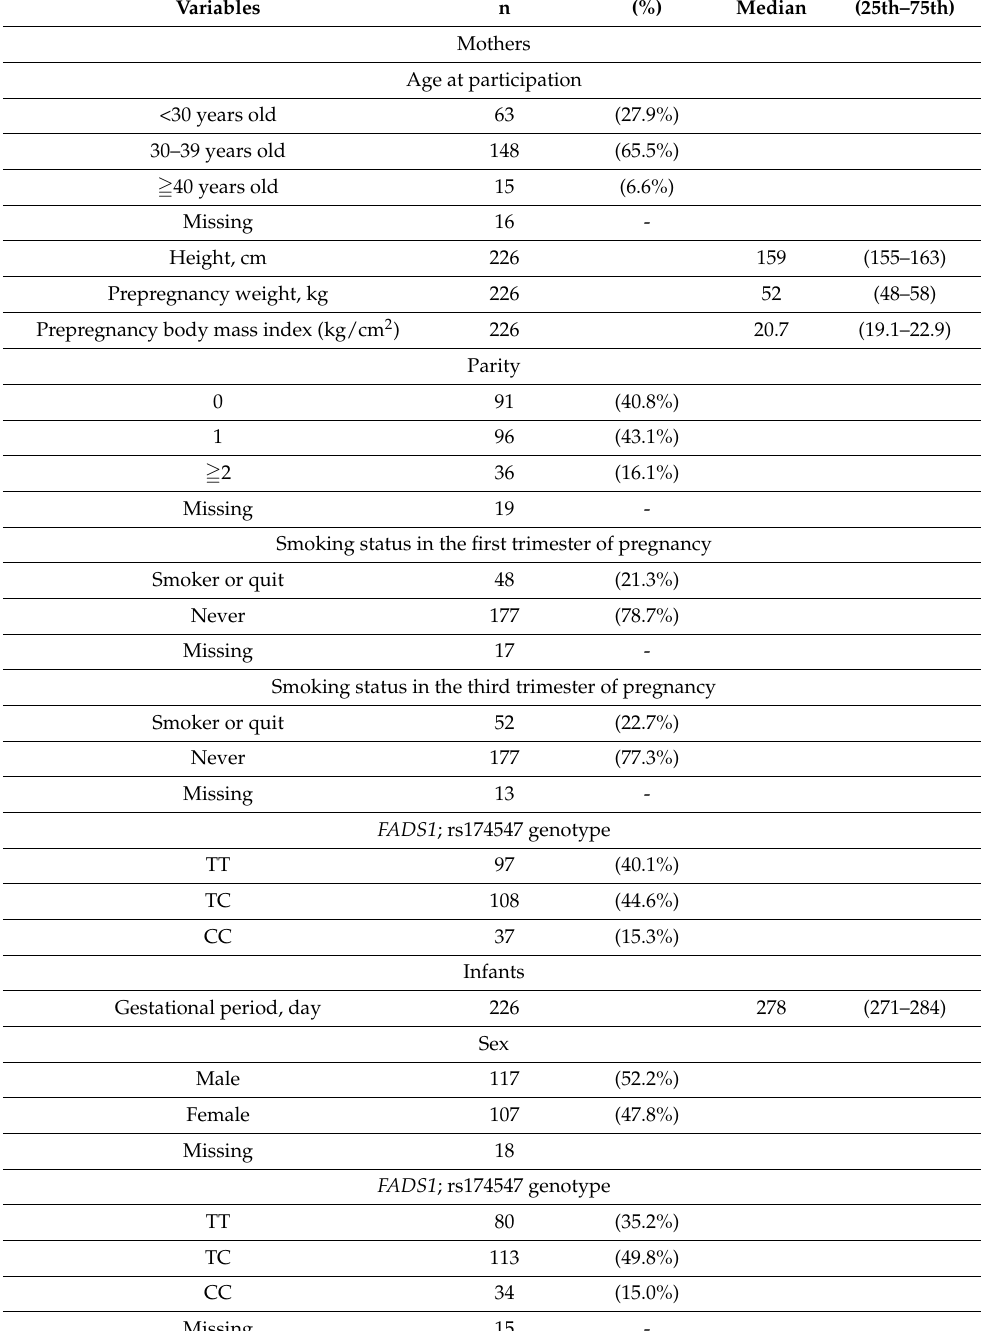
Table 1. Subject